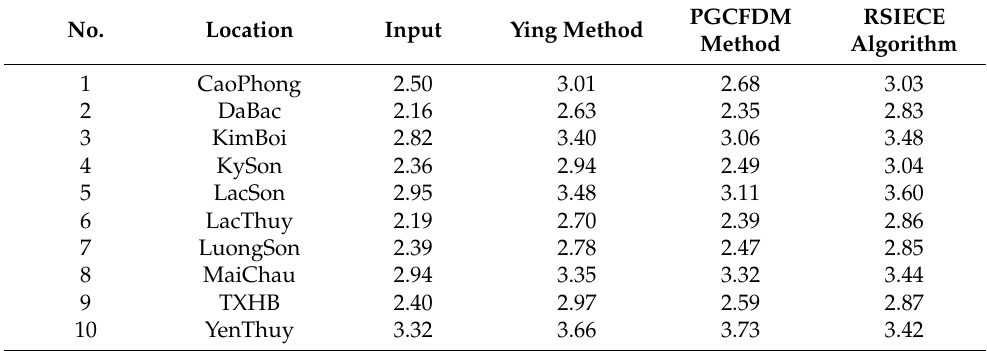
Table 4. Entropy index of enhanced images by the RSIECE algorithm compared to the Ying and PGCFDM